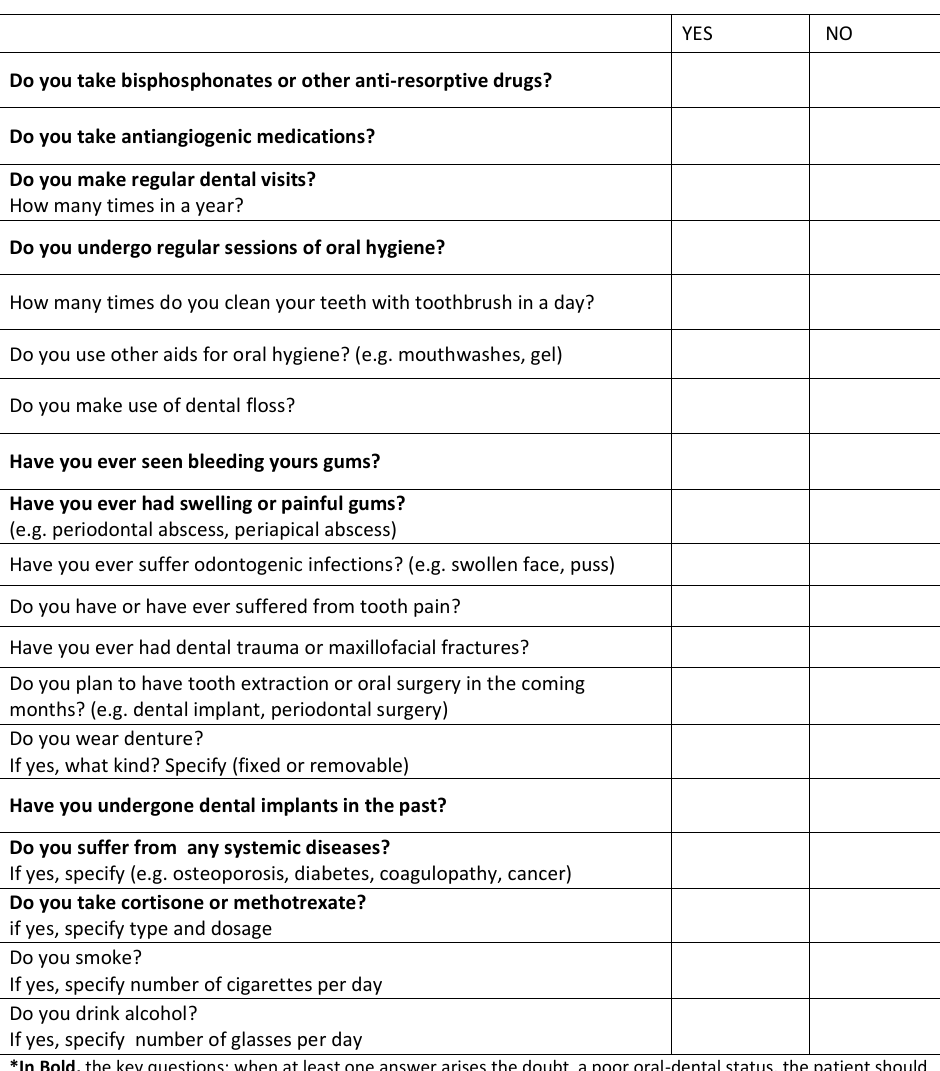
Figure 2. Questionnaire for ONJ-related drug